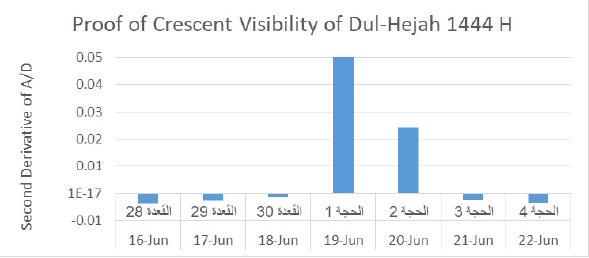
Figure 14. The Present Model Crescent Visibility of Dul-Hejah 1444 H.